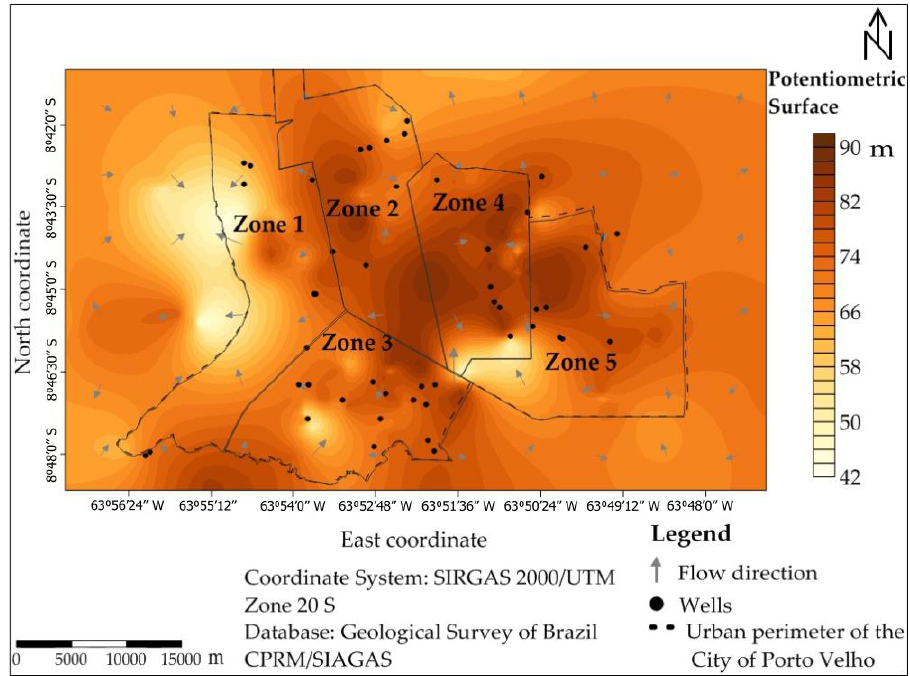
Figure 6. Underground flow within the urban perimeter of Porto Velho, RO.